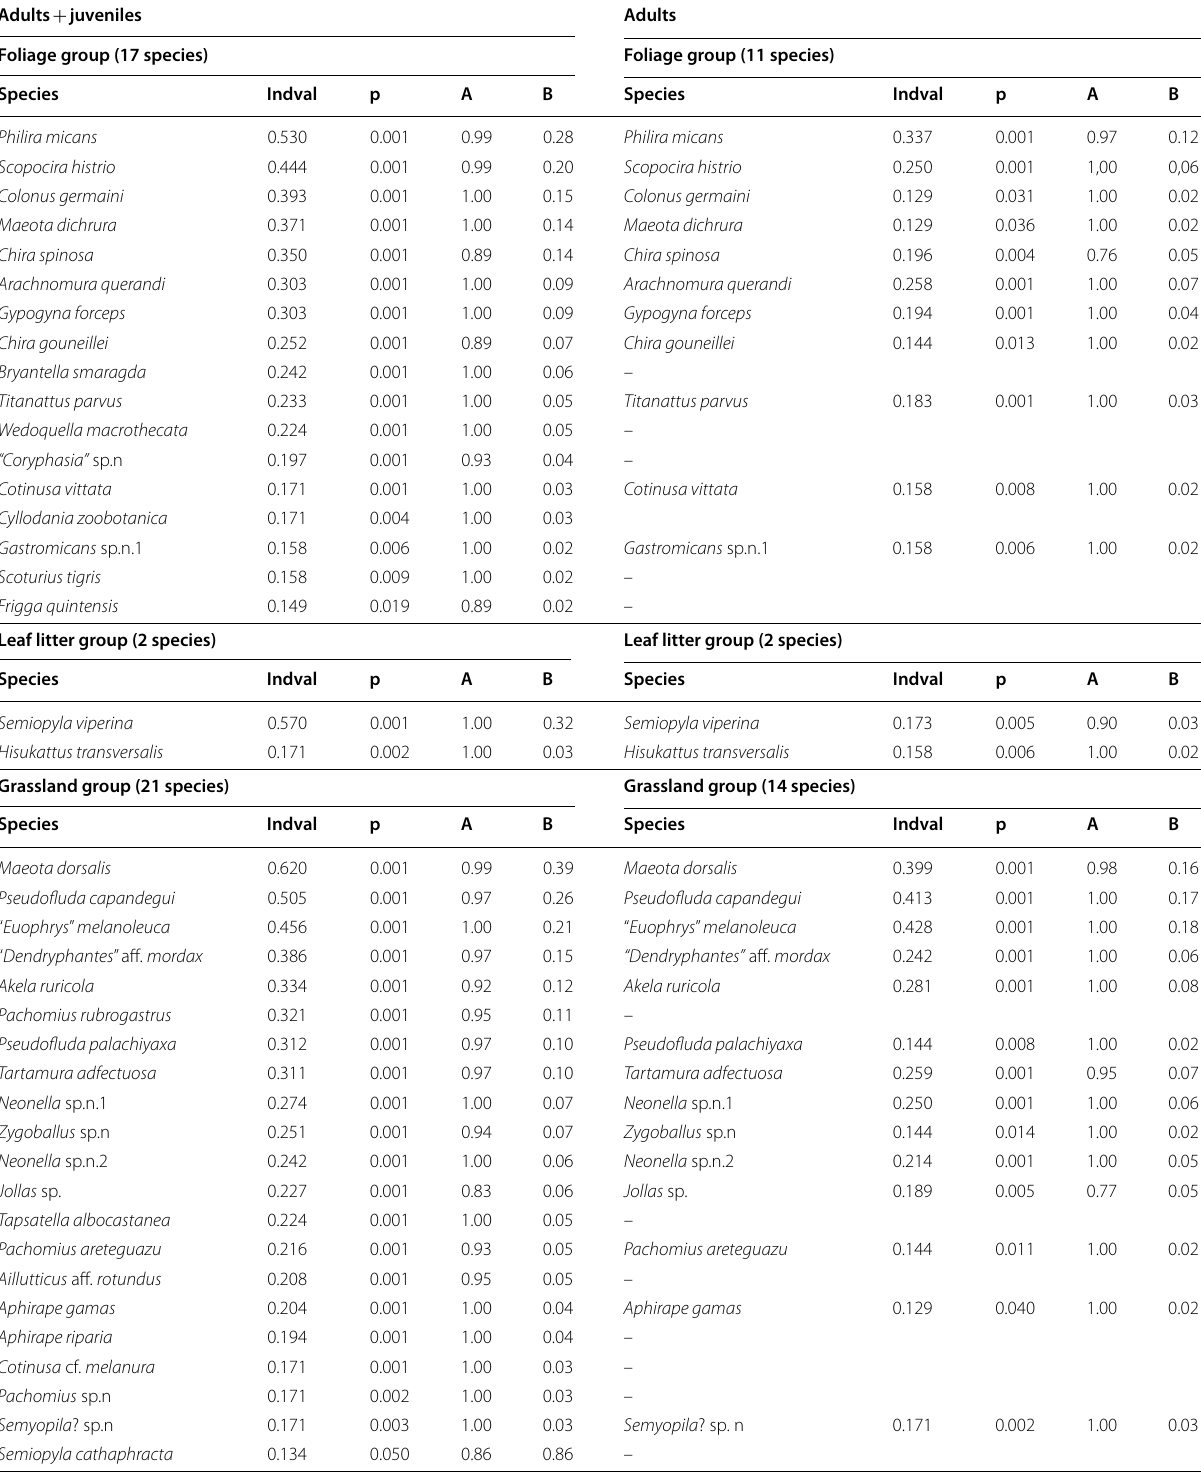
Table 1 IndVal-significant species in three habitats of the studied area, Eastern Chaco District, Argentina Adults juveniles Adults + Foliage group (17 species) Foliage group (11